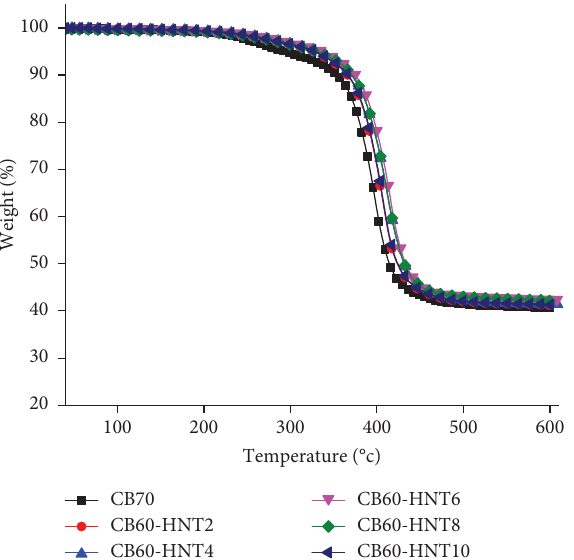
Figure 2: TGA curves of ACM composites at 10 ° C/min under nitrogen atmosphere.